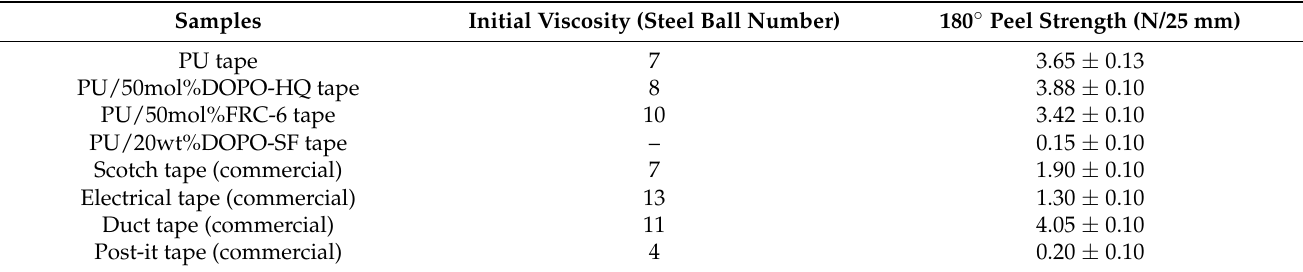
Table 6. Adhesive properties of FRPU-PSA and commercial PSA